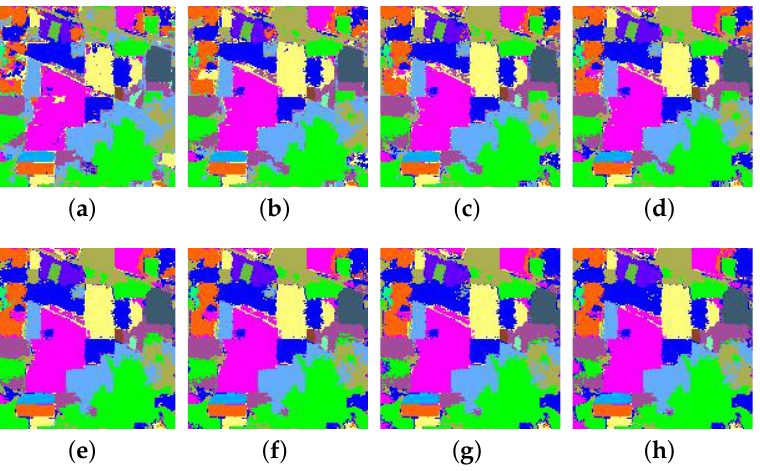
Figure 8. Full classification maps of Indian Pines data set using different numbers of learning units. ( a ) one unit; ( b ) two units; ( c ) three units; ( d ) four units; ( e ) five units; ( f ) six units; ( g ) seven units; ( h ) eight units.